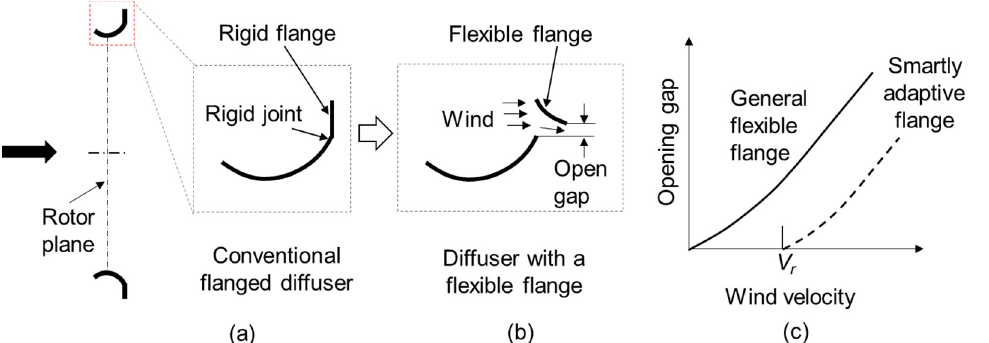
Figure 3. A general flexible flange idea: ( a ) conventional rigid flanged diffuser; ( b ) general flexible flange idea; ( c ) curves of open gap vs. wind